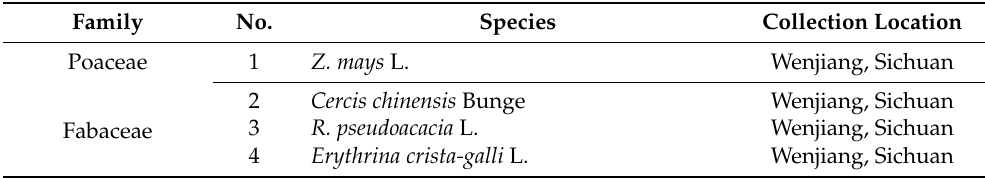
Table 1. Details of Z. mays and the 41 woody plants used in this study. Family No. Species Collection Location Poaceae 1 Z. mays